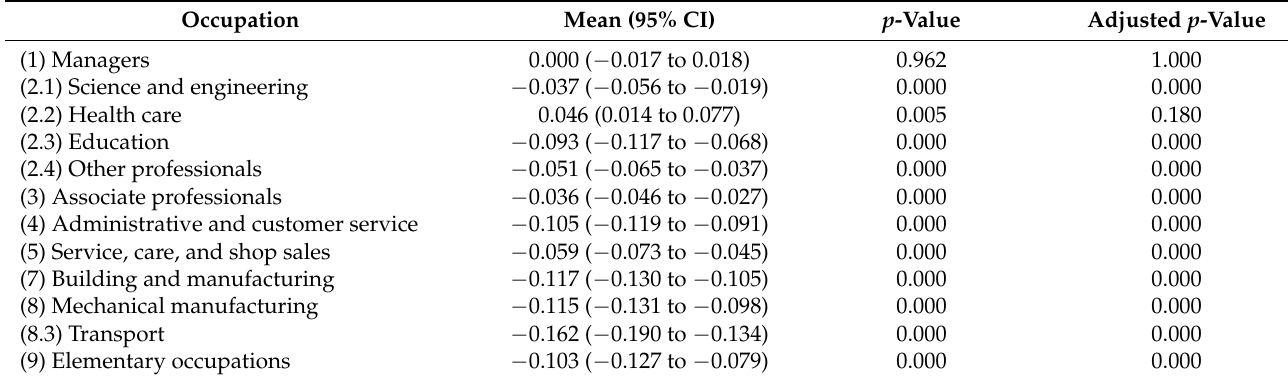
Table A1. Main effects of the linear regression model.